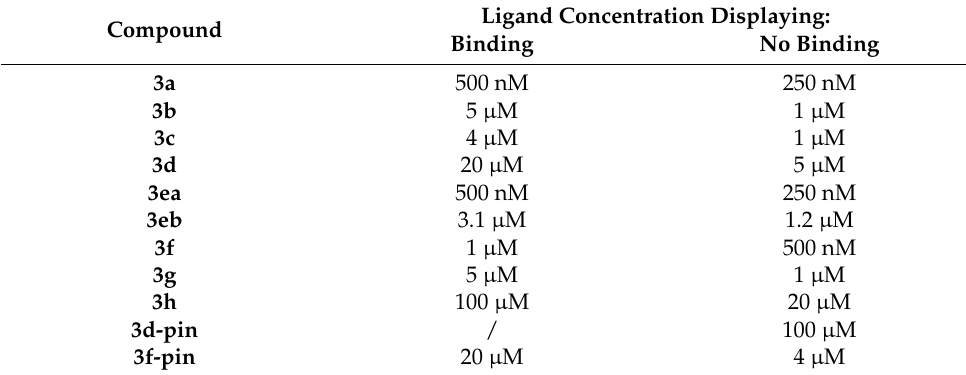
Table 2. Results of the MST binding check assays.